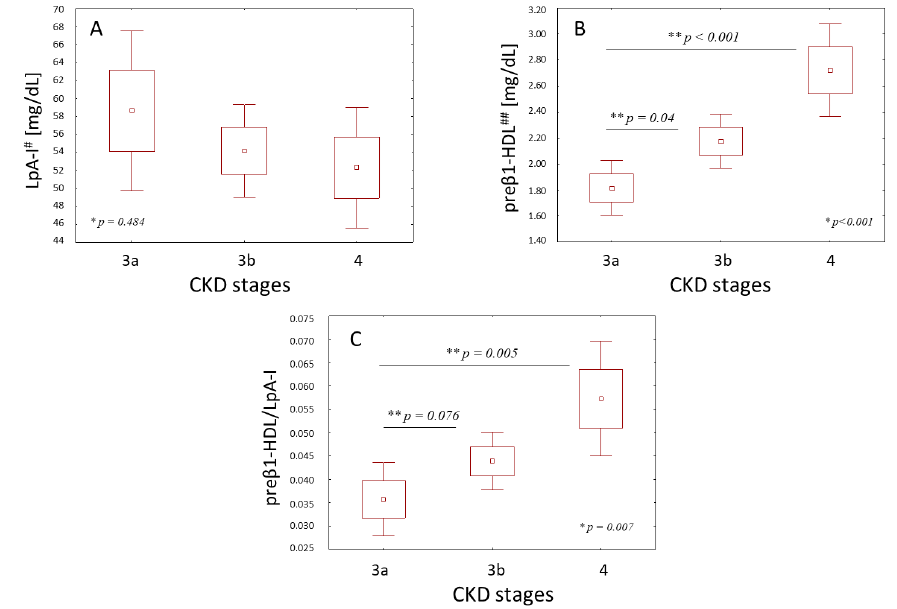
Figure 1. HDL containing apolipoprotein A-I without apolipoprotein A-II (LpA-I) ( A ), the pre β 1-